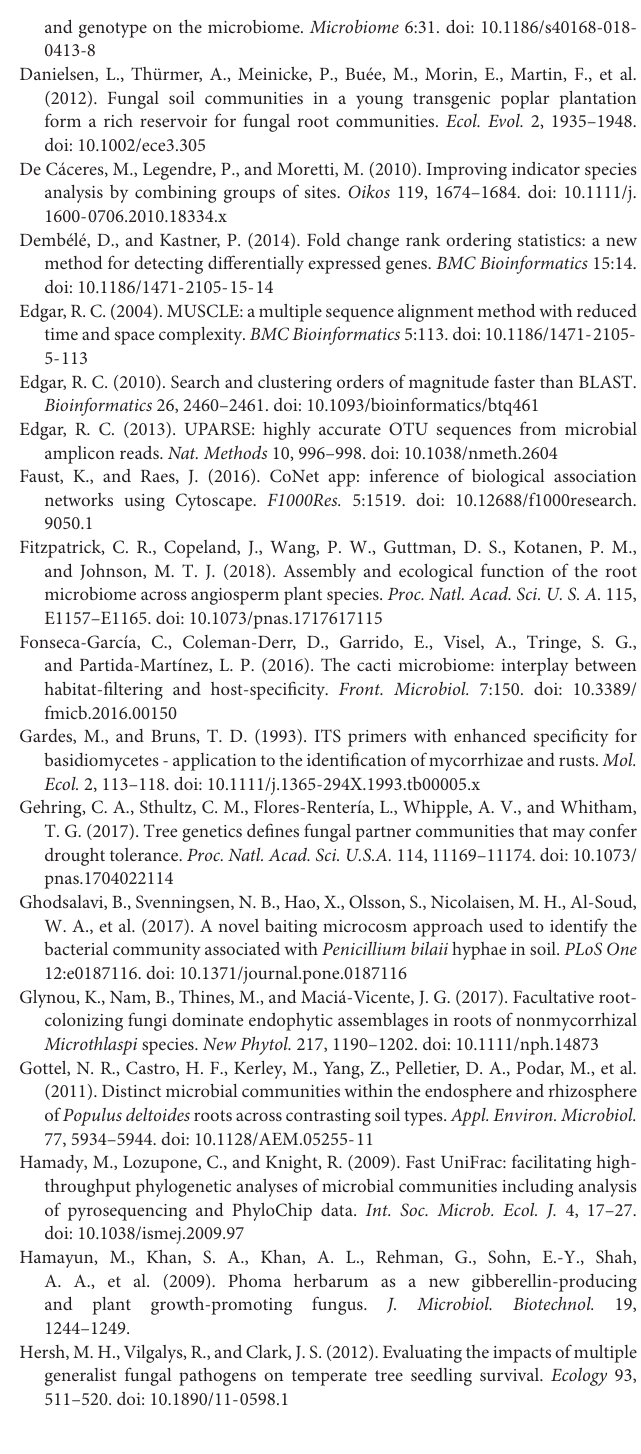
TABLE S7 | Summary of the sizes of Markov Cluster (MCL) communities for Experiment 1, as we as the number of fungi vs bacterial members. TABLE S8 | Operational taxonomic units (OTUs) assigned to Markov Cluster (MCL) communities for Experiment 2, as well as various network topology measures each OTU node in the pearson correlation network the communities were constructed from.